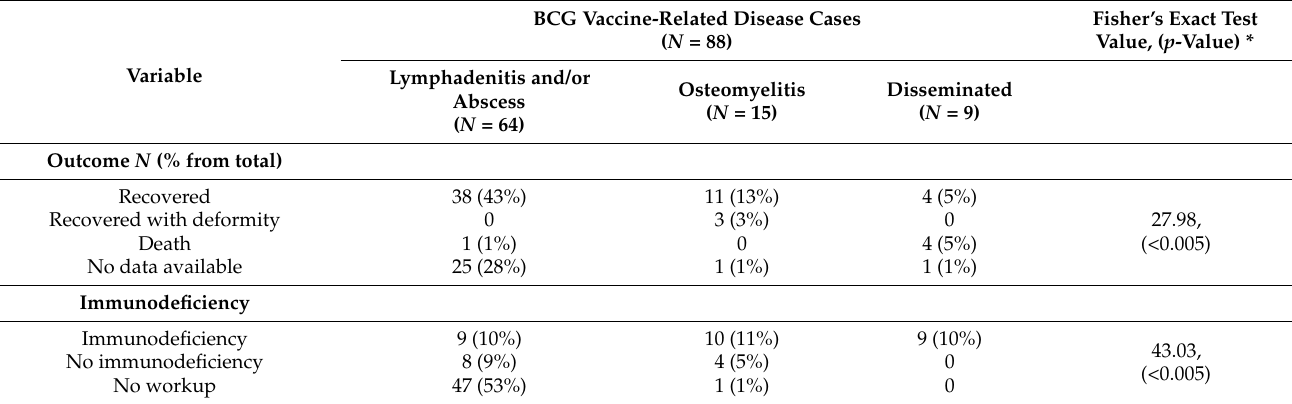
Table 3. Outcome and immunodeficiency status in each type of BCG vaccine-related disease.